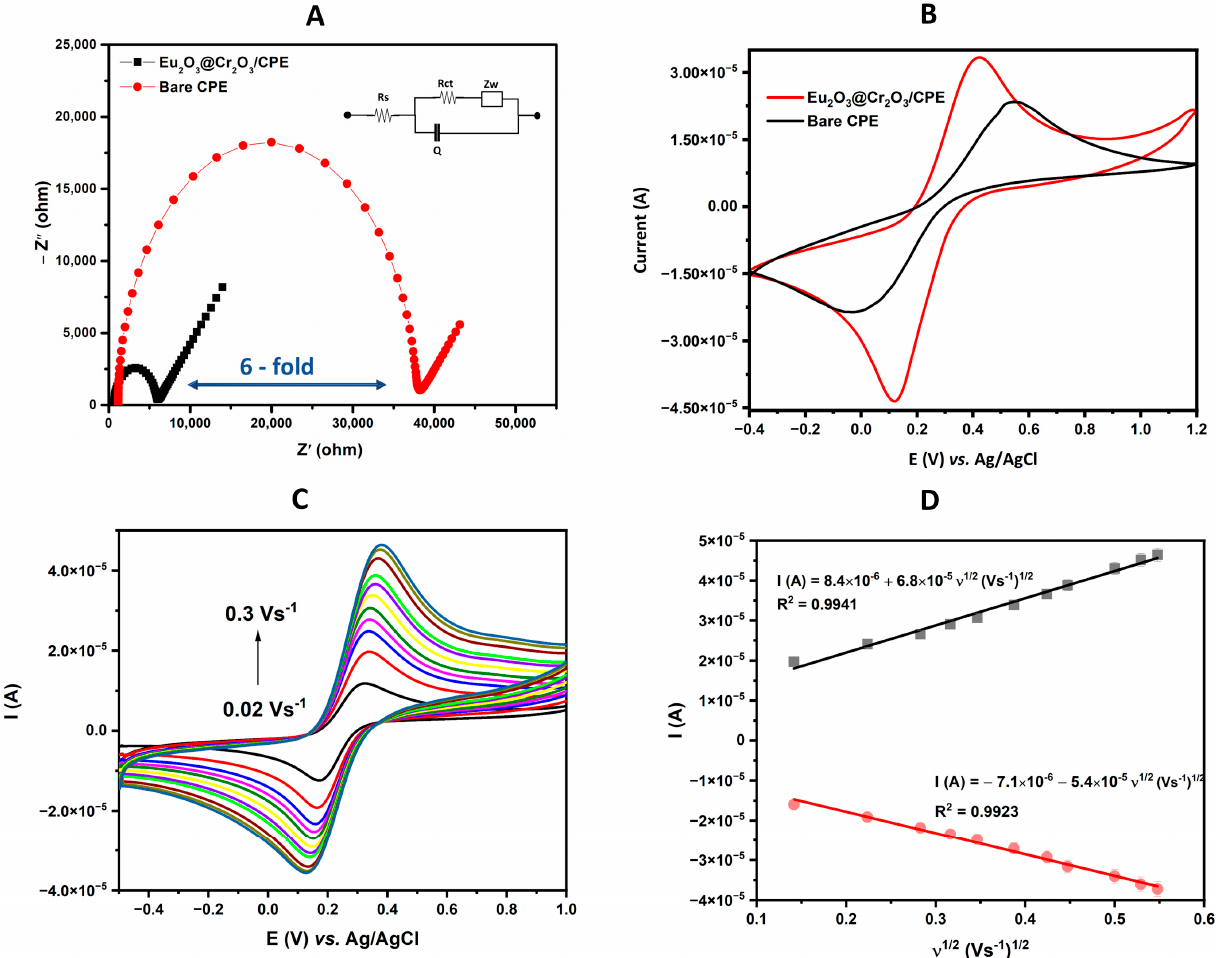
Figure 2. ( A ) EIS curves of bare CPE and Eu 2 O 3 @Cr 2 O 3 /CPE in a 0.1 KCl solution containing 5 mM [Fe(CN) 6 ] 3 − /4 − and ( B ) CV curves of bare CPE and Eu 2 O 3 @Cr 2 O 3 /CPE (scan rate 0.05 V s − 1 ). ( C ) CV redox current curves for Eu 2 O 3 @Cr 2 O 3 /CPE at scan rates from 0.02 to 0.3 V s − 1 . ( D ) Fitted plots of the redox current response vs. the square root of the scan rates. The aforementioned CV investigations were recorded in 5 mM [Fe(CN) 6 ] 3 − /4 − with 0.1 M KCl solution (potential window for CV − 0.5 to 1.0 V).